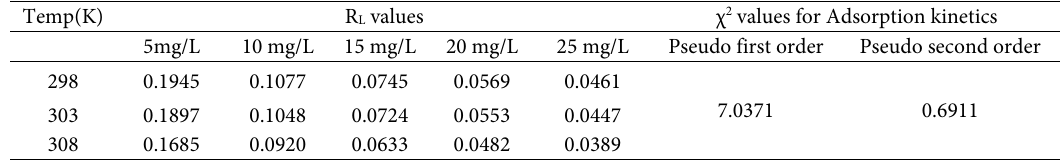
Table 5. Values of R and χ 2 of Cu (II) adsorption onto L